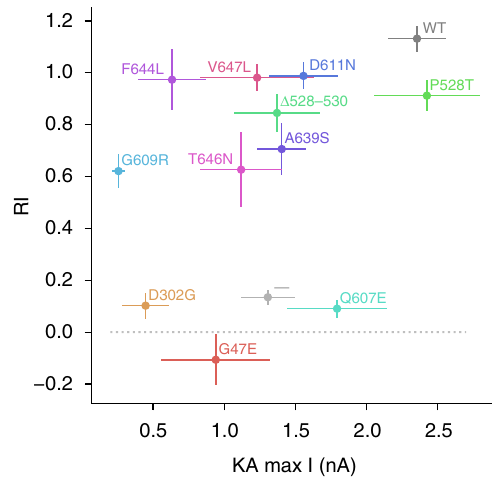
Fig. 8 Scatter plot summarizing changes in current amplitude and recti fi cation when GluA2 is co-expressed with GluA1 in HEK cells. Relationship between RI and KA-evoked current amplitude for mutant GluA2, compared to WT and negative (GluA1) control ( — ). Error bars are SEM